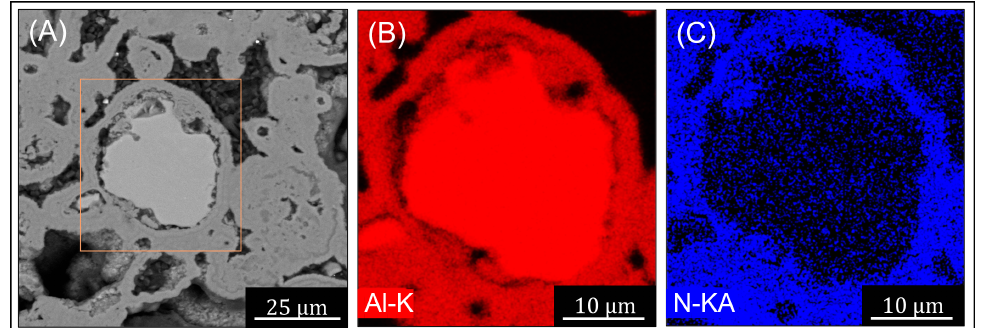
Figure 7. SEM micrograph and EDS maps of powder after nitriding at 510 °C for 6 h: ( A ) SEM micrograph of nitride Al particle, ( B ) EDS map Al-K Map and ( C ) EDS map N-KA.